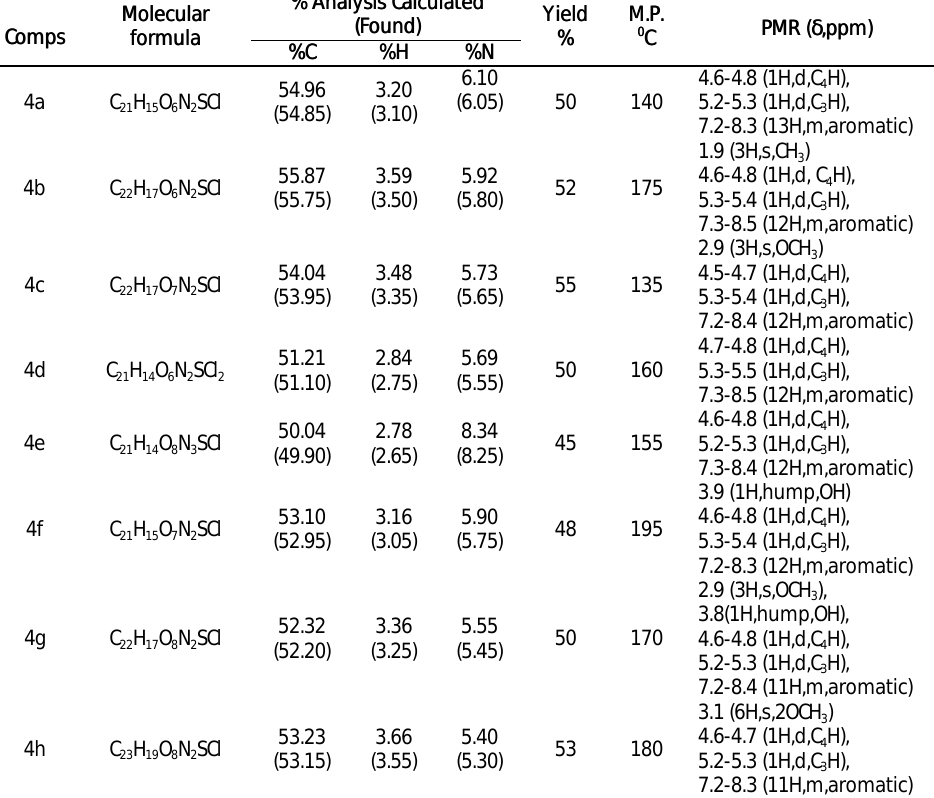
Table Table –– 1 1 Analytical and Spectral data of Compounds (4a Analytical and Spectral data of Compounds